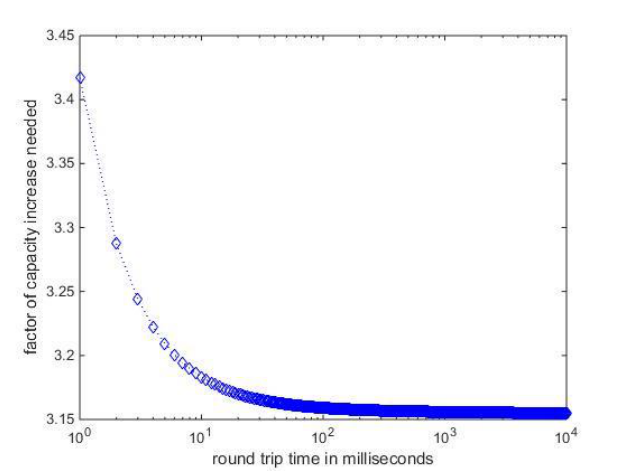
Figure 3. Capacity increase factor for C = 1Gbps and Q=10000